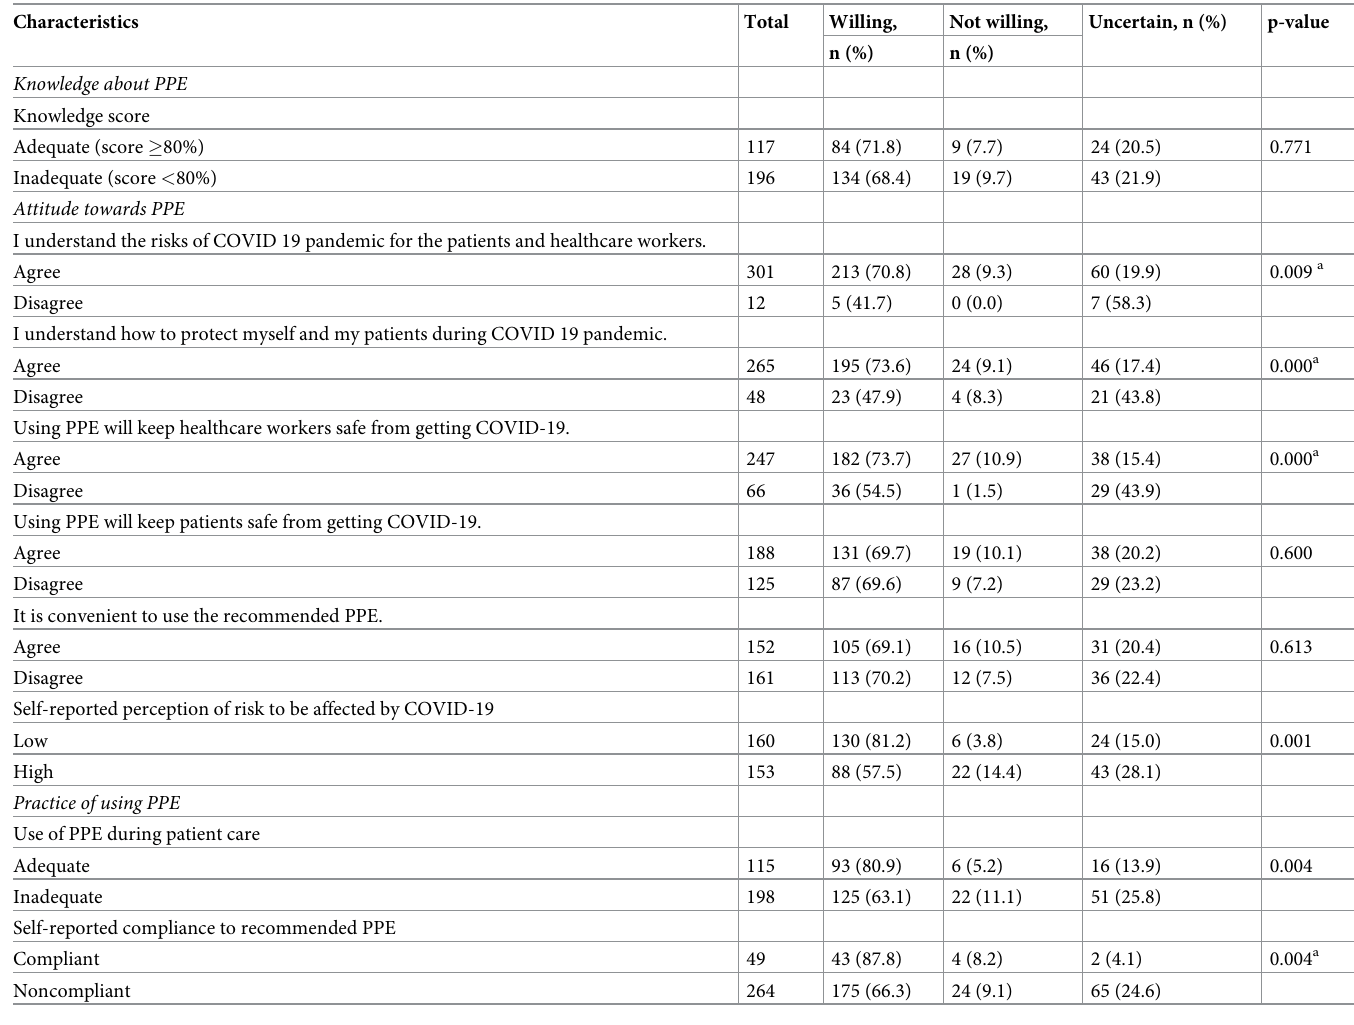
Table 2. Knowledge, attitude, and practice of protective measures against SARS-CoV-2 among the participants (n = 313).